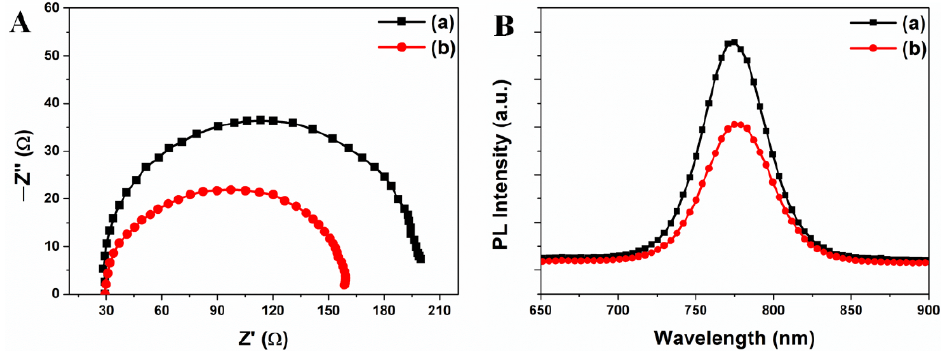
Figure 9. ( A ) shows the electrochemical impedance spectroscopy of perovskite solar cells with a non-nanopatterned ( a ) and nanopatterned ( b ) TiO 2 thin-film layer. ( B ) shows the photoluminescence (PL) spectra of perovskite solar cells with a non-nanopatterned ( a ) and nanopatterned ( b ) TiO 2 thin-film layer.